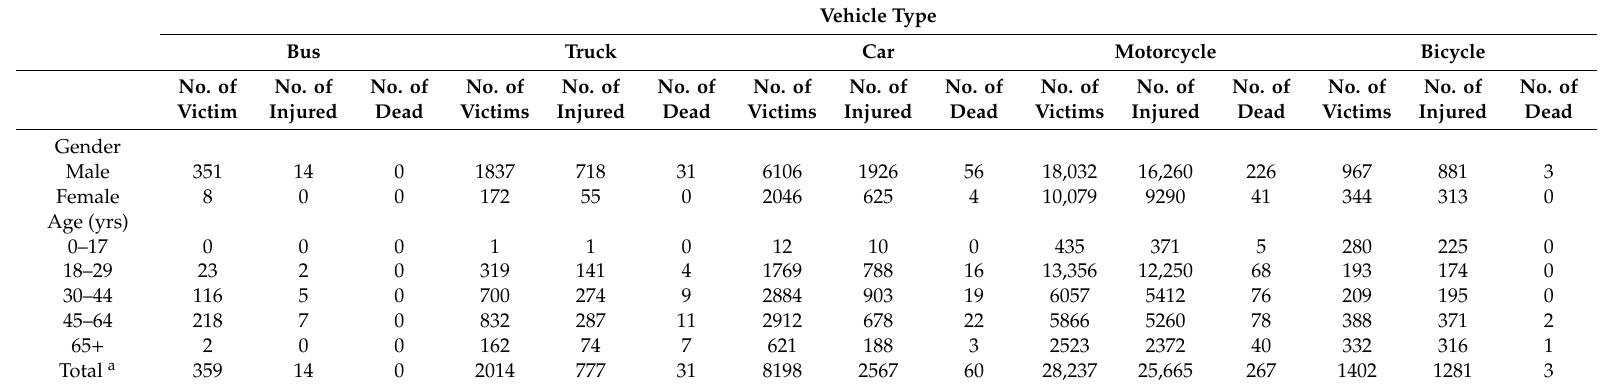
a Di ff erence between the total number by gender and age constituted uninformed